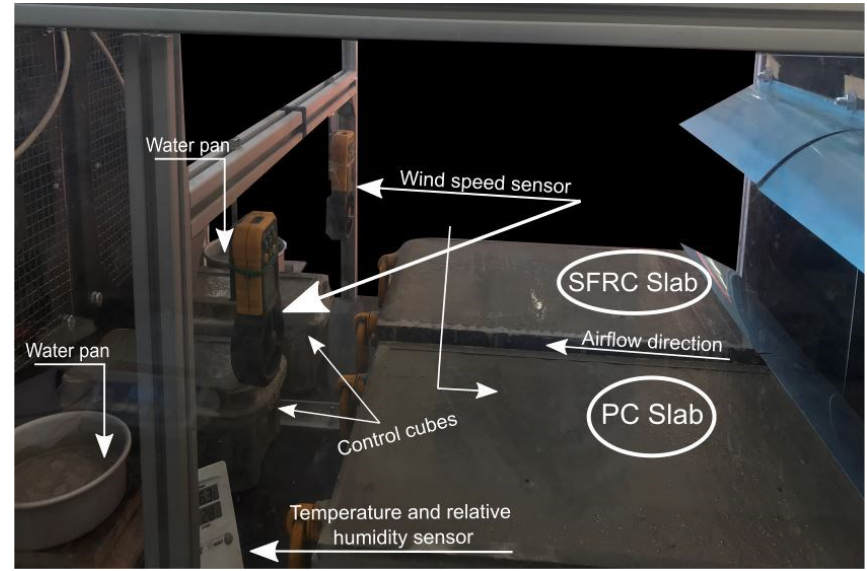
Figure 11. Set-up for plastic shrinkage